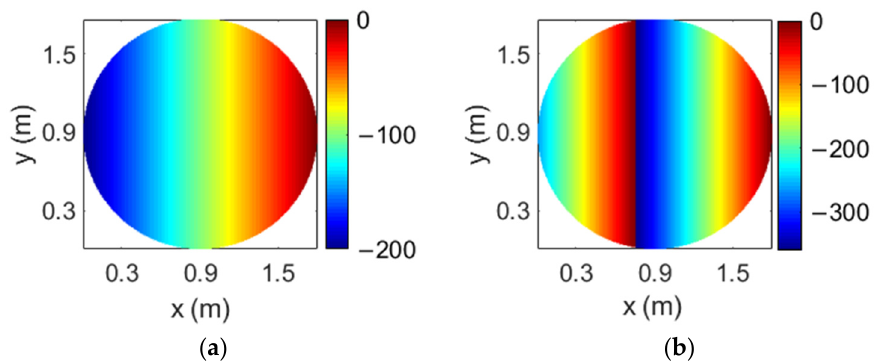
Figure 9. Required phase distributions of the 1.8 m parabolic reflectarray at the ( a ) lower and ( b ) upper operating frequencies for the same CP.